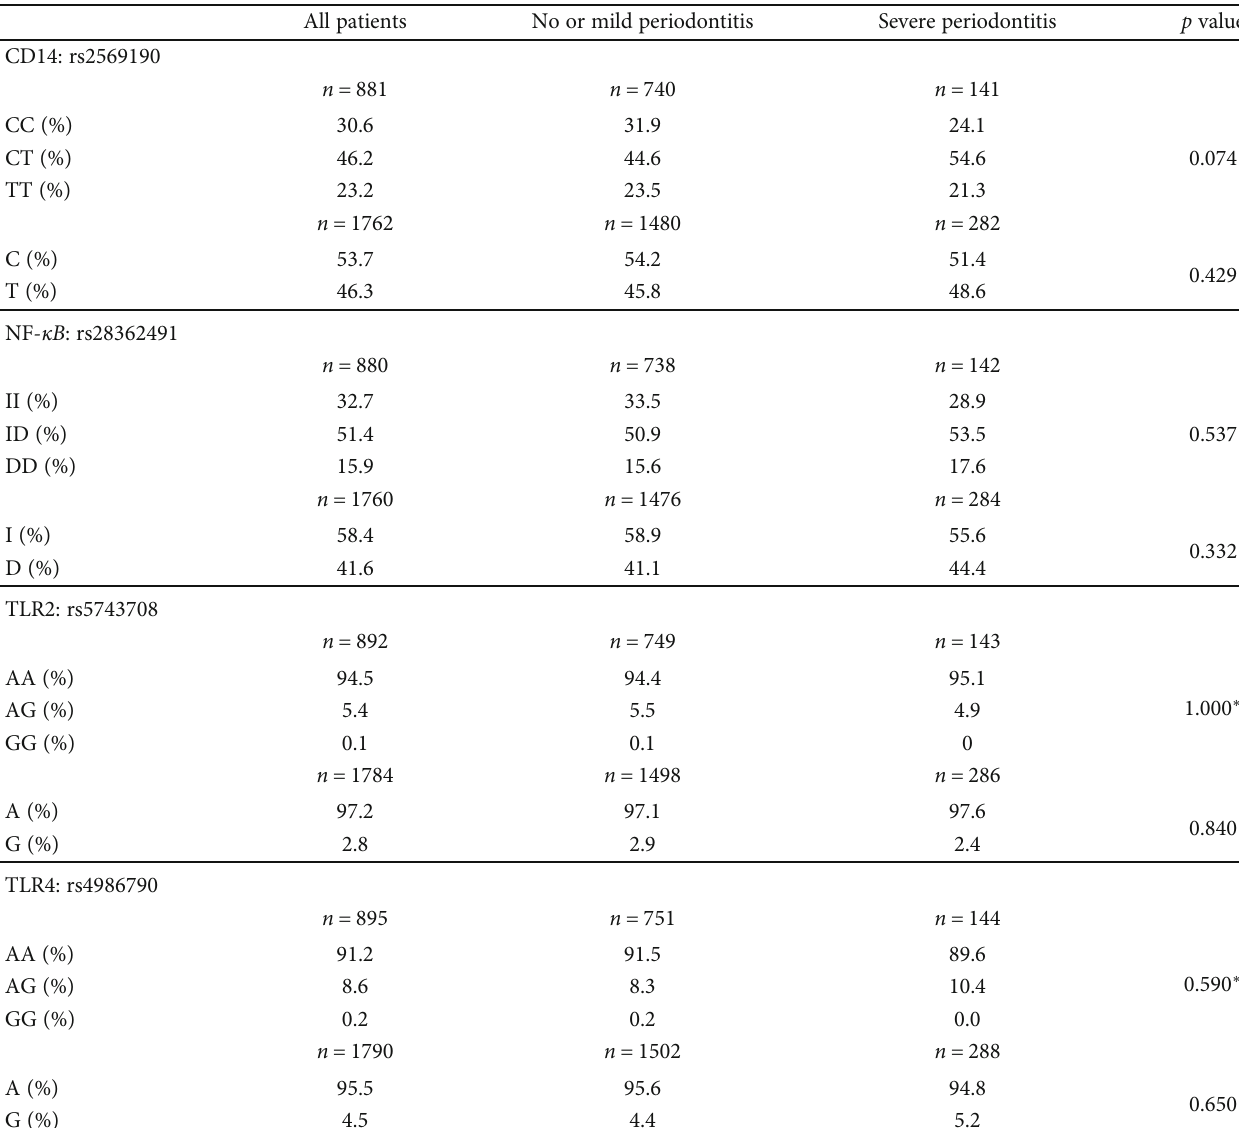
Table 4: Association of genotype and allele distribution of SNPs in CD14. NF- κ Β . TLR2 and TLR4 and occurrence of combined endpoint (stroke/TIA. myocardial infarction. Cardiovascular death. Death from